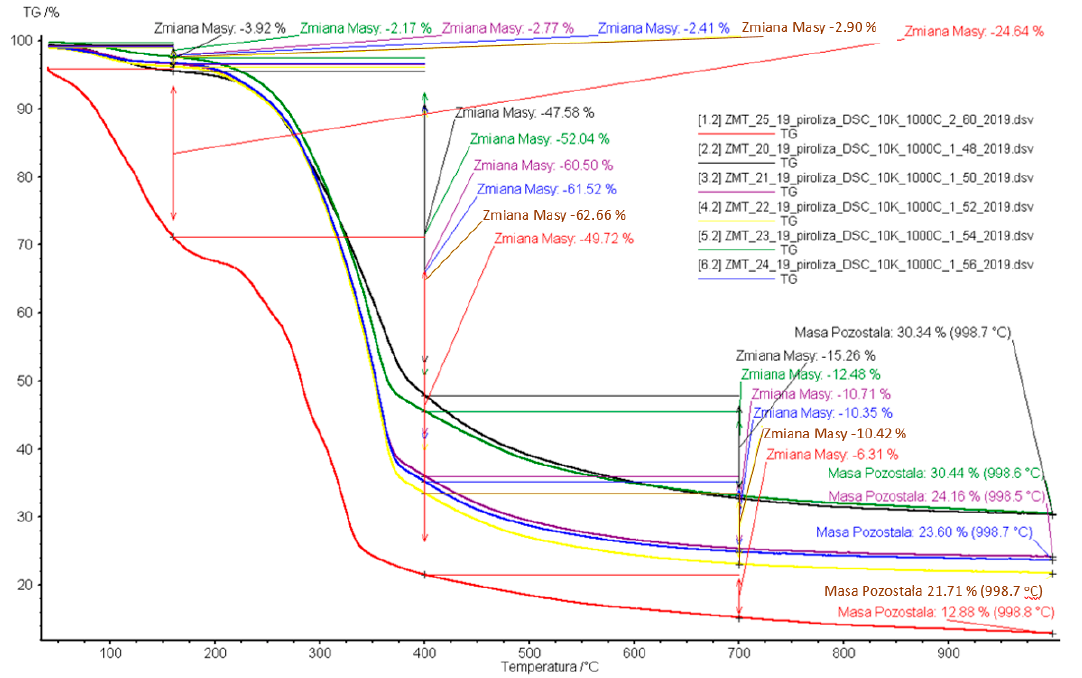
Figure 2. TG (thermogravimetry) curves of all the samples tested (own research).